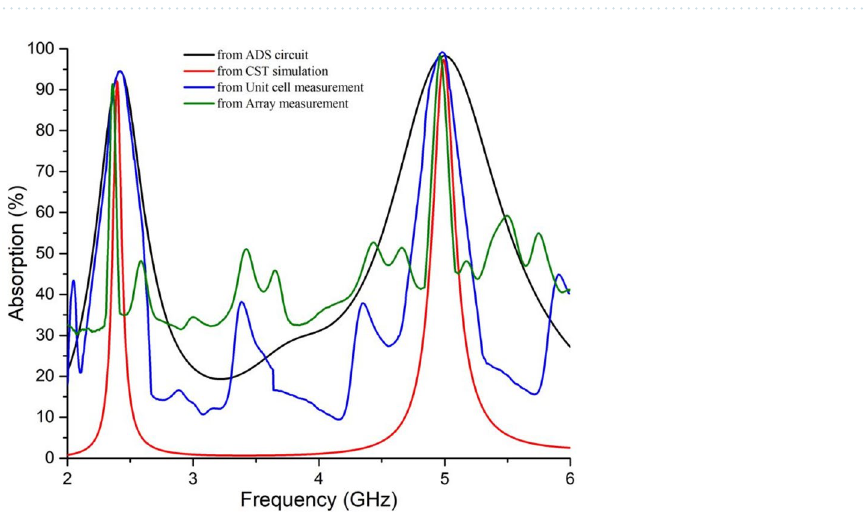
Figure 11. Fabricated unit cell ( a ) measurement setup of the unit cell with a vector network analyzer (VNA), ( b ) fricated array patch, ( c ) fabricated array ground, ( d ) array measurement setup in the anechoic chamber.